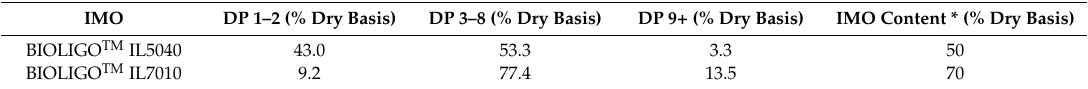
Figure 4. Post-prandial glycemic response to BIOLIGO TM IL5040 and BIOLIGO TM IL7010 IMO (Study 2). Data are mean ± SEM. Table5. Compositional differences of tested IMOs.